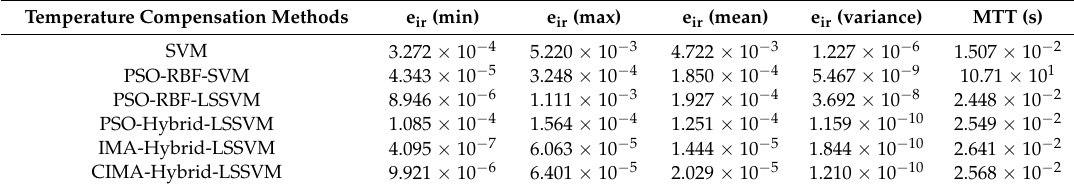
Table 5. Compensation results of training set by fixed